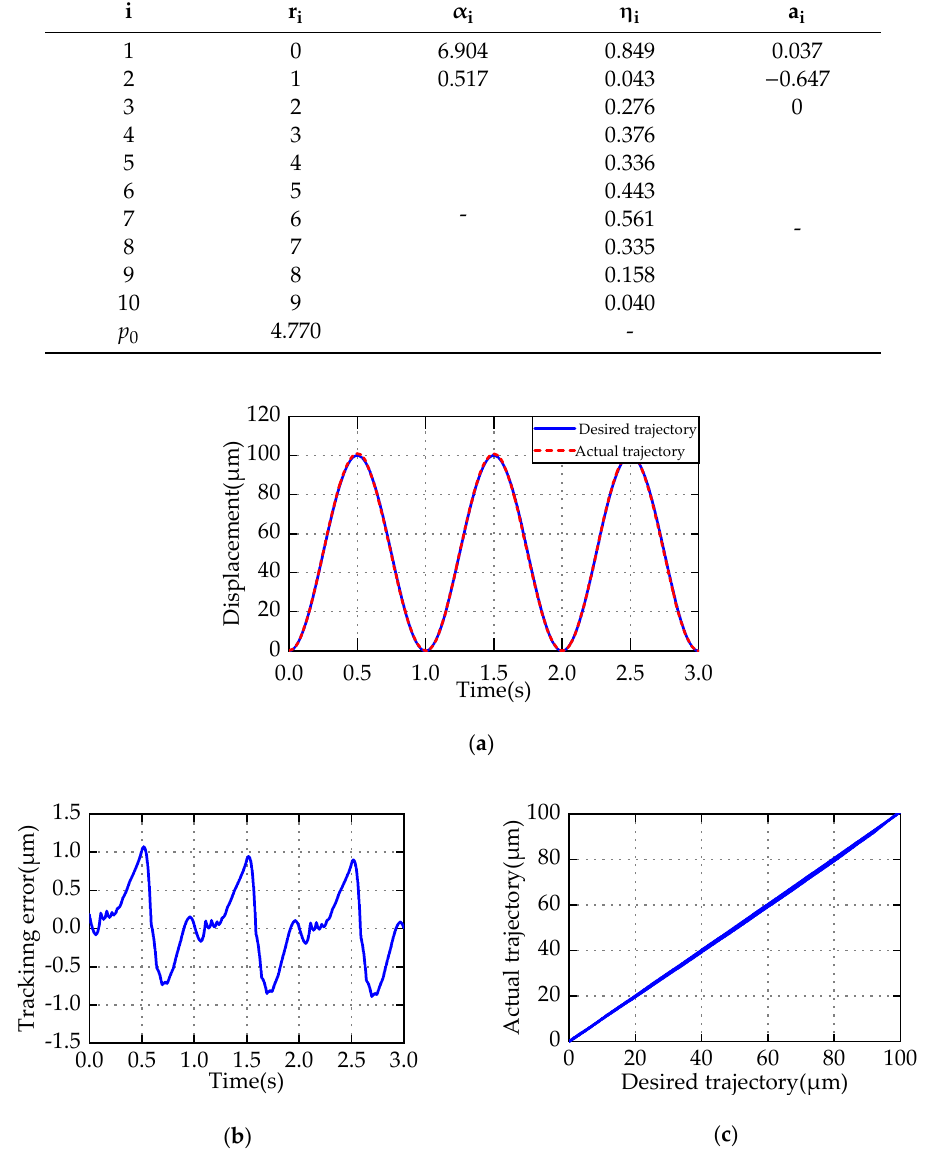
Figure 14. Periodic sinusoidal reference tracking experiment. ( a ) Trajectory tracking; ( b ) tracking error; ( c ) the relationship between desired and actual displacement. Table 4. The identified parameters of PMPI model.